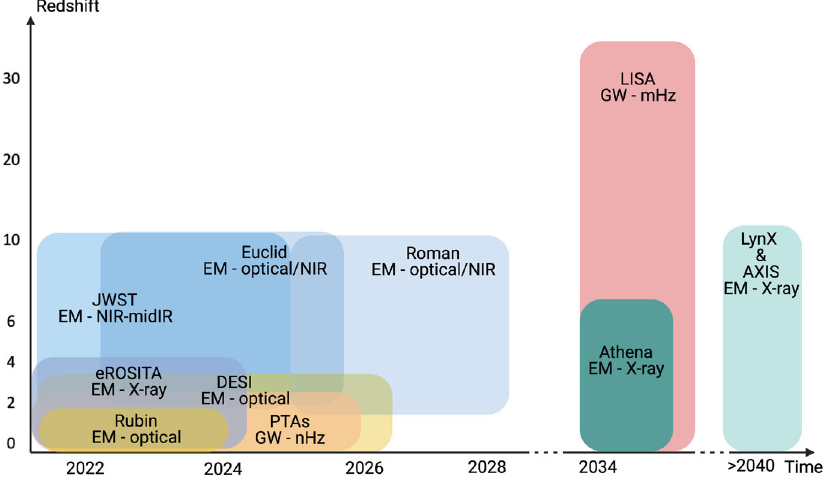
Fig. 29 Landscape of the upcoming and concept missions aiming at constraining the population of MBHs and their host galaxies, from the local to the high-redshift Universe. These missions will signi fi cantly increase current EM detections towards high redshifts ( z (cid:1) 10), while LISA will reach redshifts (e.g., z > 30) that will not be available with EM observations. We caution that the timelines reported in the fi gure are only indicative as delays in the launch of any of the missions, especially those a few years away from the time of writing, are always possible. In addition, at the time of writing the likely launch time- frame for ATHENA is set to slightly earlier than that of LISA. Characteristics of these and other missions are listed in Table 7. Image credit: Melanie